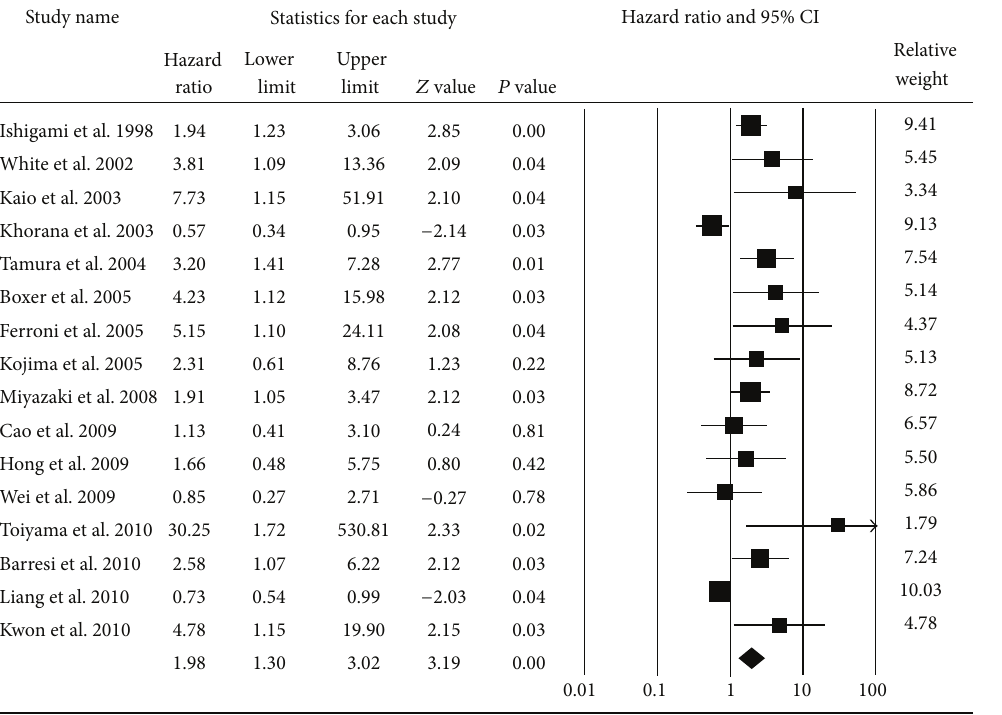
Figure 2: Forest plot for the association between VEGF expression and overall survival of CRC. The squares and horizontal lines represent the HRs and 95% confidence intervals (CIs) in the individual studies; the size of each square represents the weighting assigned to the corresponding study. The diamond indicates the pooled HRs.